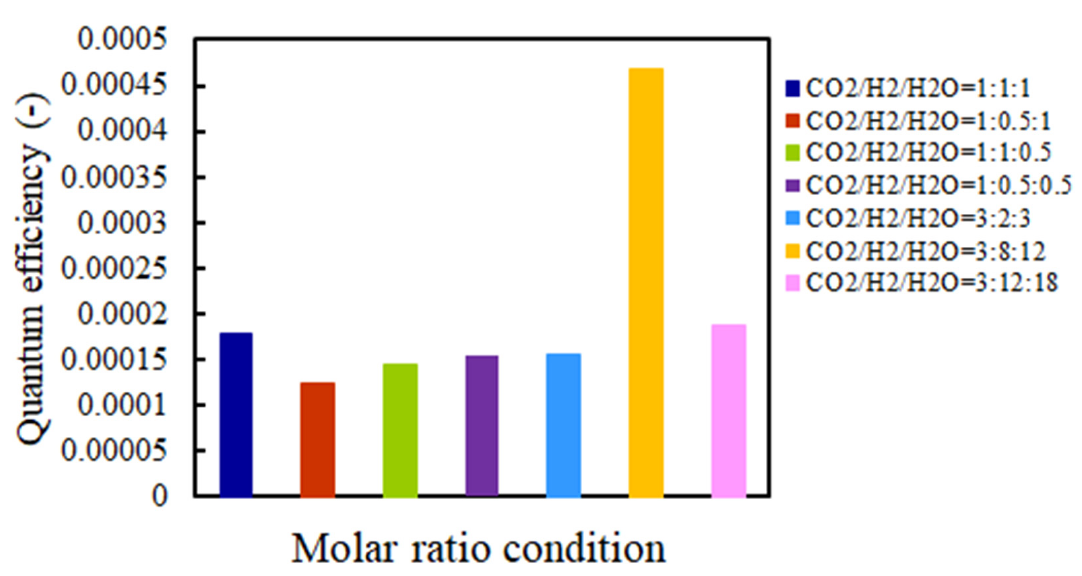
Figure 8. Comparison of quantum efficiency among different molar ratios with UV light. The pulse number is 200. The highest quantum efficiency is obtained under the condition of the molar ratio of CO 2 /NH 3 /H 2 O = 3:8:12.